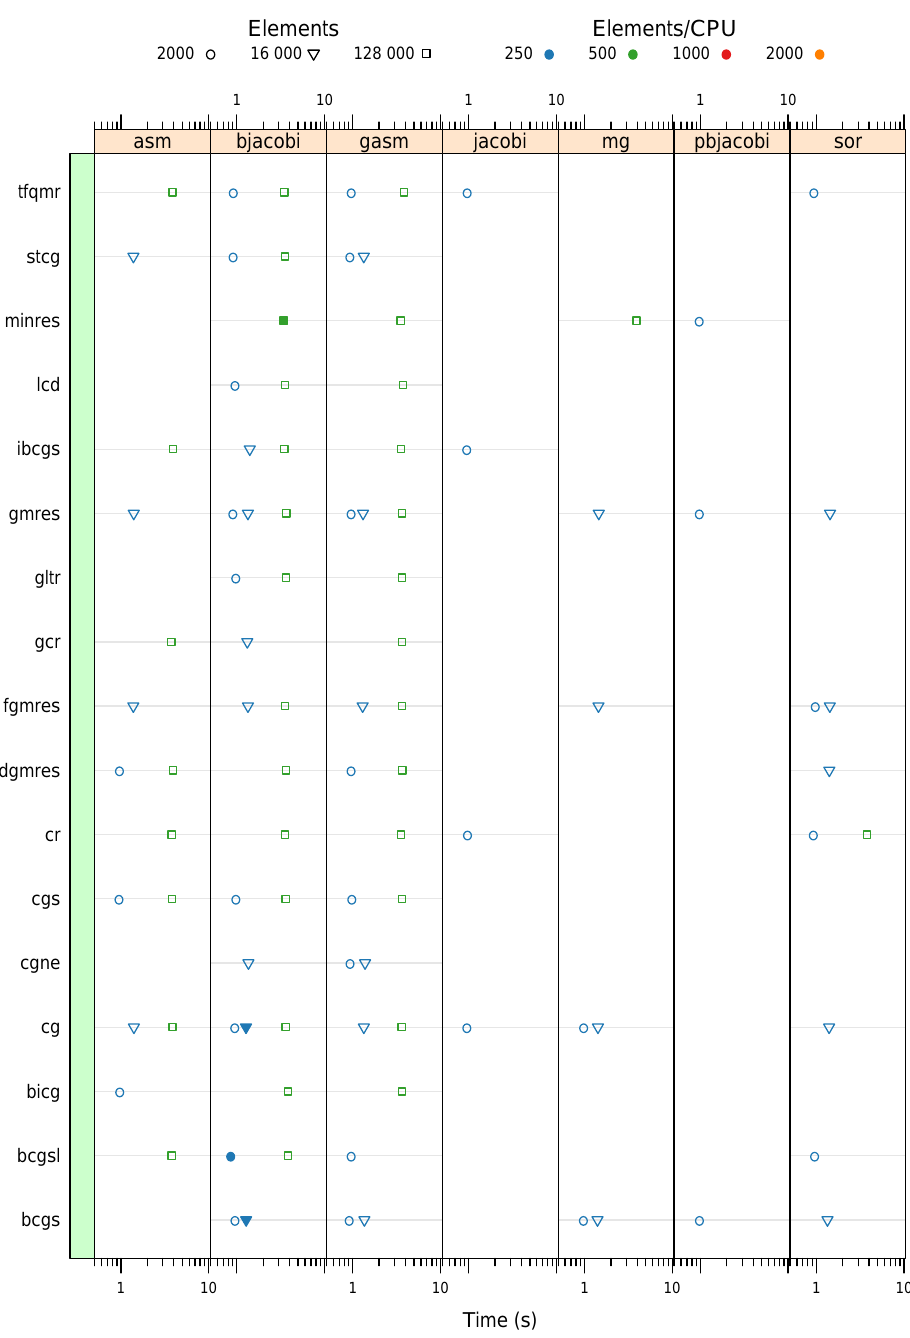
Figure 7. Horizontal velocity analysis: timing results for the fastest solvers (top 15%) tested on ISMIP-HOM Experiment A. The top (1%) timing results are distinguished using color-filled symbols. See Fig. 2 for more